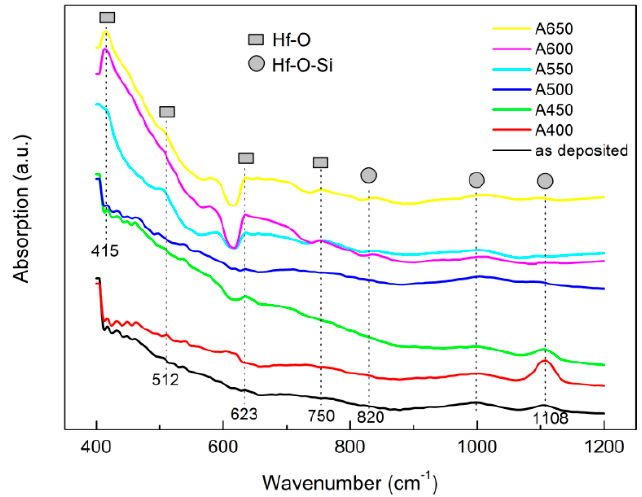
Figure 1. Fourier transformation infrared spectra of HfO 2 /Si samples with different annealing temperatures.